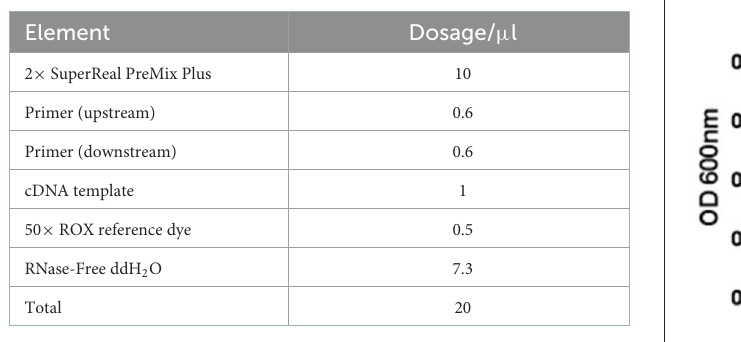
TABLE 4 Fluorescence quantitative PCR reaction system.